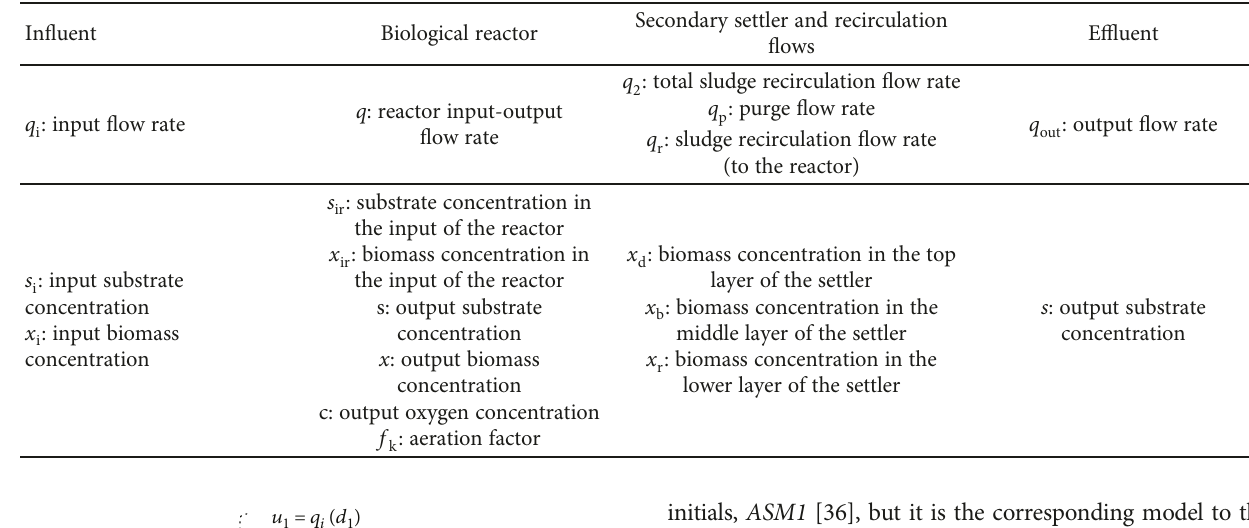
Table 1: Main variables of the WWTP with activated